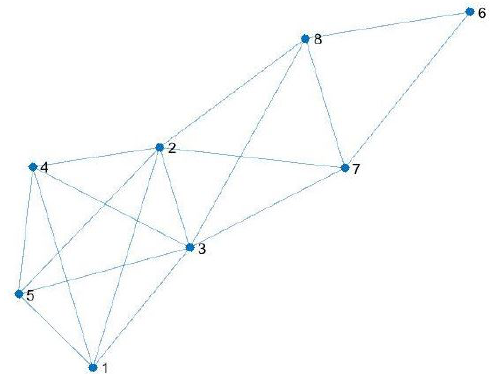
Figure 6. The graph G ( δ ) with δ = 0.5 for N = 8 assets. Vertex number refers to the associated asset. In G ( δ ) , we clearly detect the three maximal cliques C 1 = { 1, 2, 3, 4, 5 } ; C 2 = { 6, 7, 8 } ; and C 3 = { 2, 3, 7, 8 } . In particular, cliques C 1 and C 2 refer to the two clusters of assets in Figure 1. The simulated graphs G S ( δ ) are presented in Figure